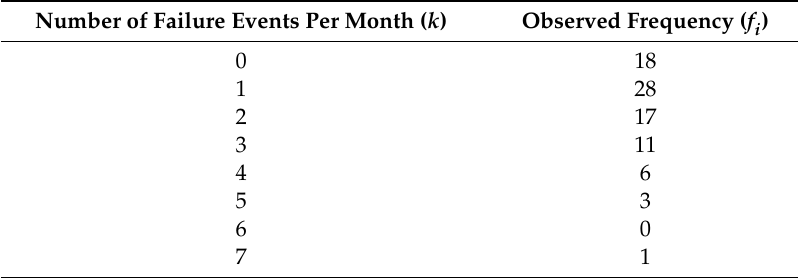
Table 1. Frequency distribution of the number of pipeline failure events per month in